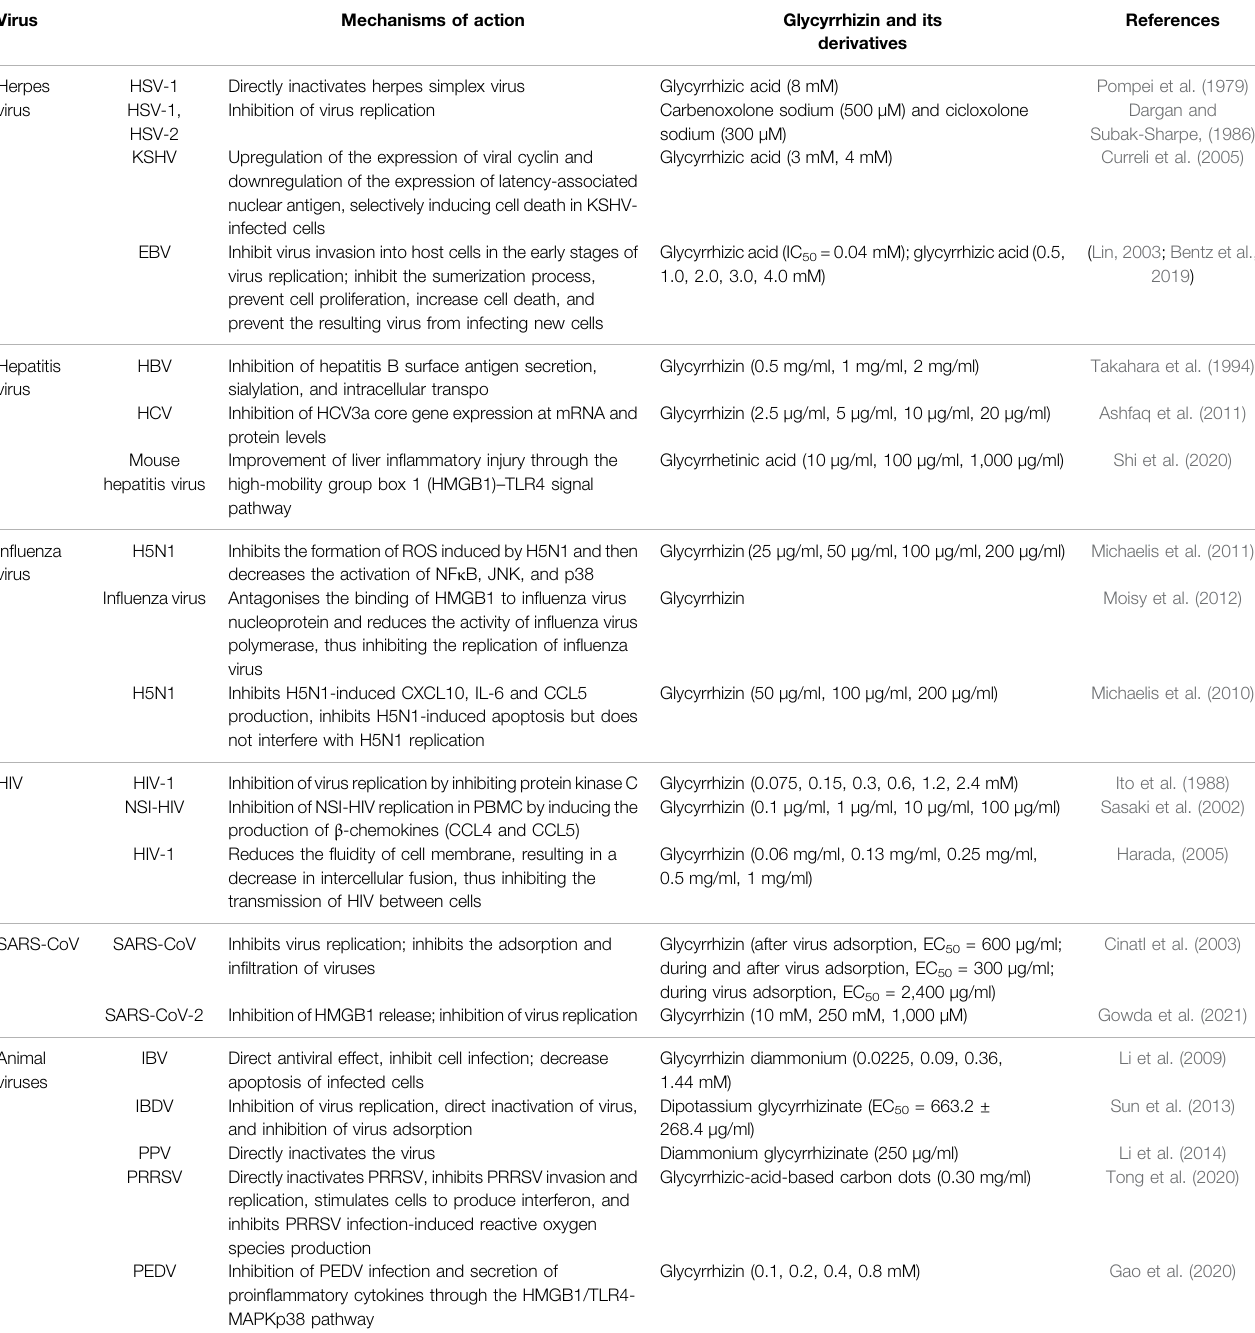
TABLE 1 | The antiviral activity and mechanism of actions of glycyrrhizin and its derivatives.